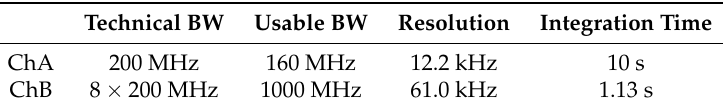
Table 1. Overview of the channel configuration of the USRP used for this study. Both channels (ChA and ChB) are electrically equal, but ChB takes advantage of frequency scanning for larger Bandwidth (BW) at the cost of a lower total integration